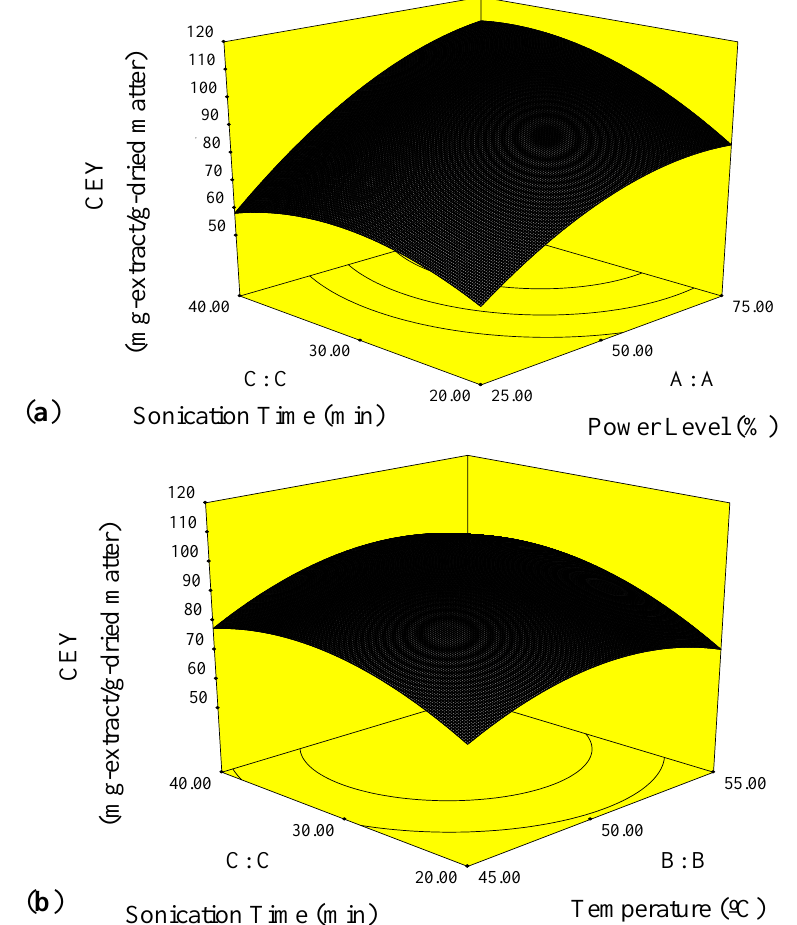
Figure 3. Response surface plots for CEY (mg-extract/g-dried matter) as a function of: ( a ) power level (%) and sonication time (min) ( b ) temperature (°C) and sonication time (min). Design-Expert® Software Factor Coding: Actual